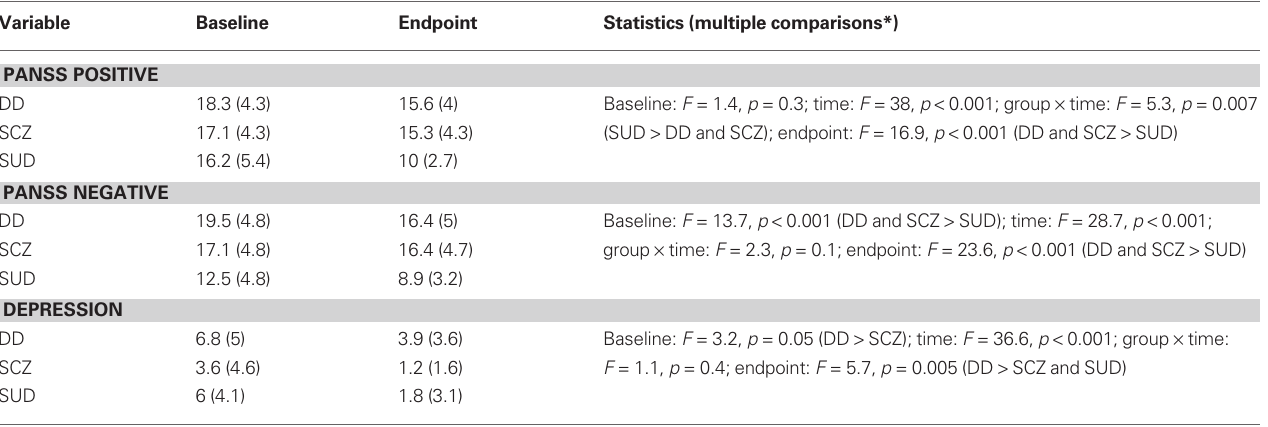
Table 4 | Psychiatric symptoms at baseline and